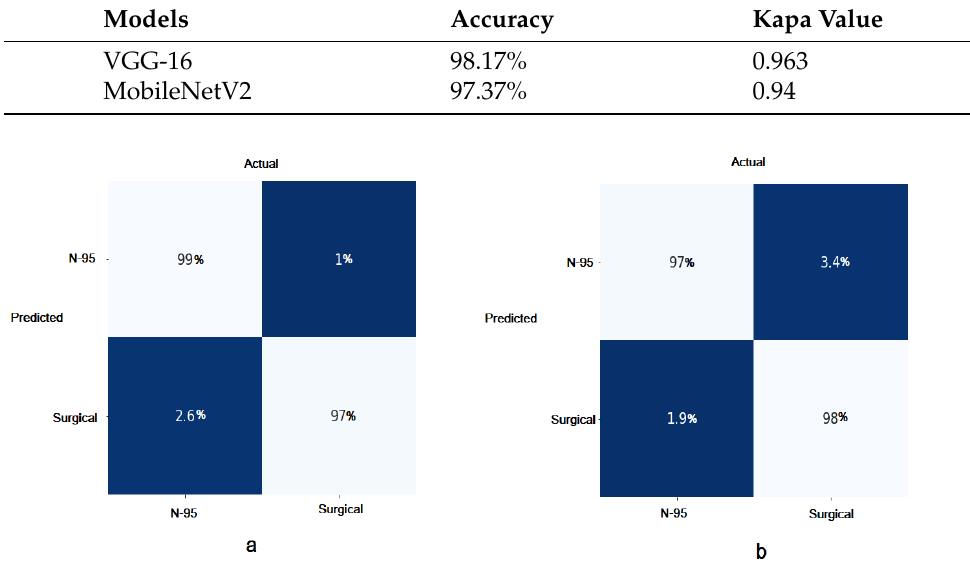
Table 9. Comparative results of the models for types of face masks detection and classification.